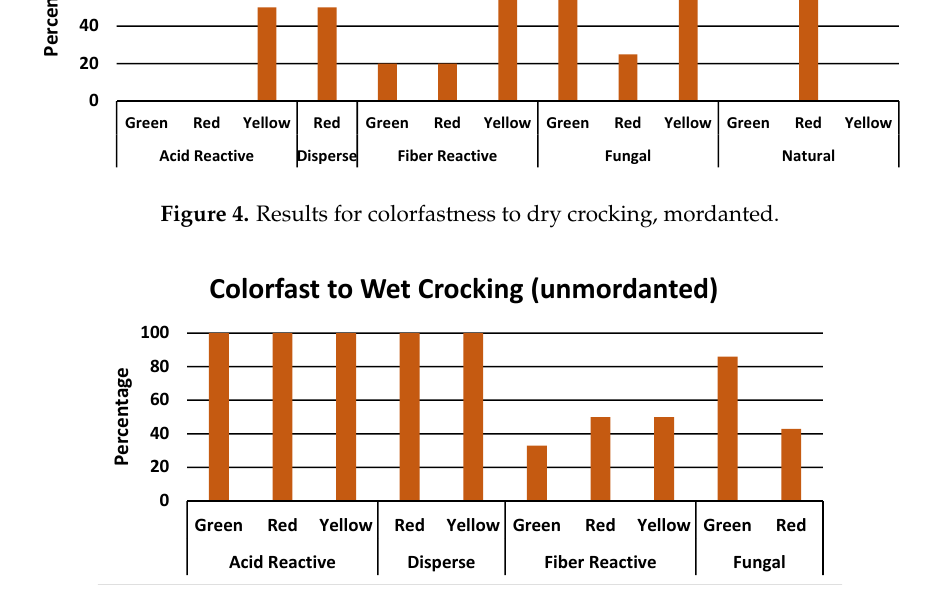
Figure 5. Results for colorfastness to wet crocking, unmordanted.